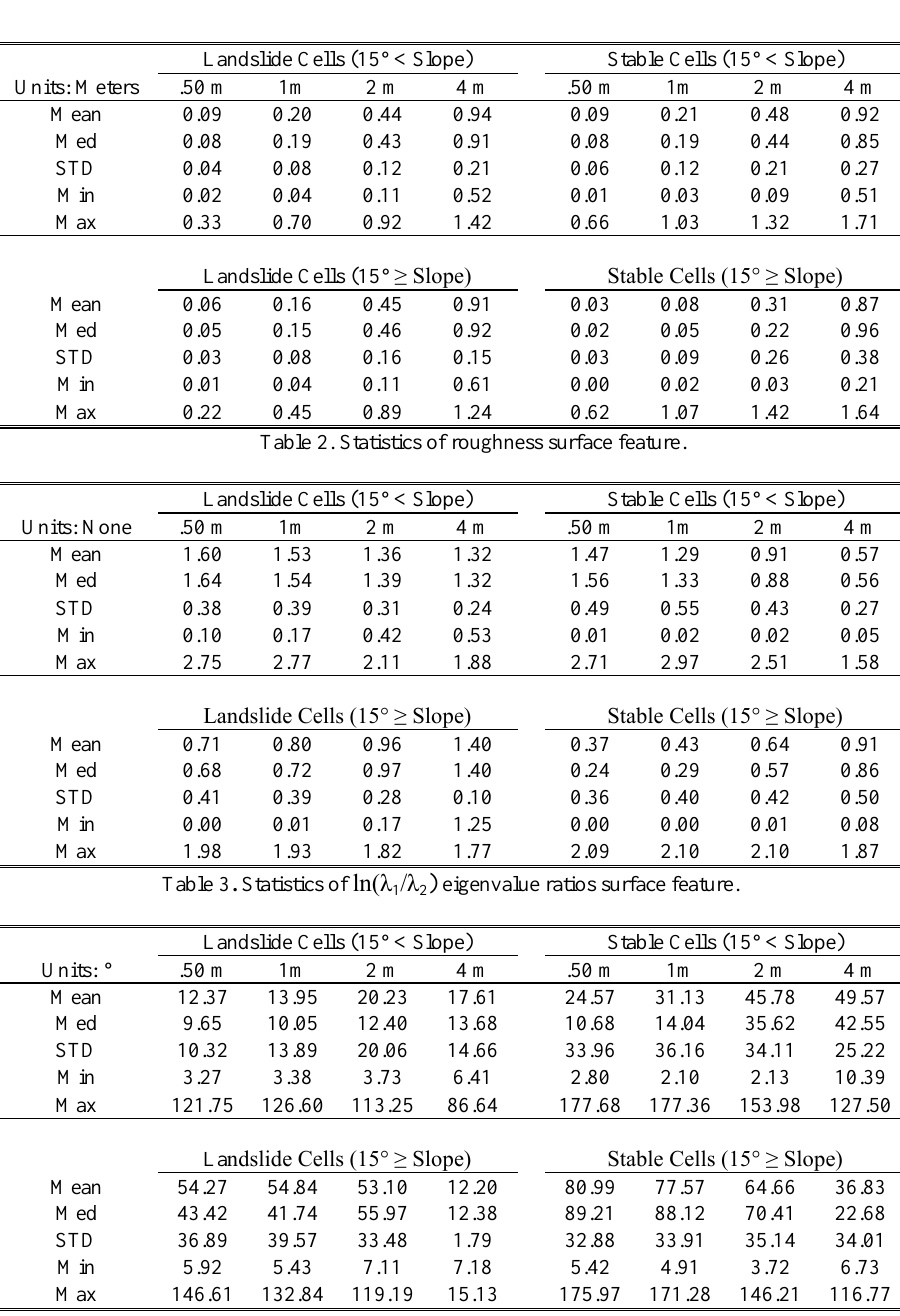
Table 4. Statistics of aspect surface feature.